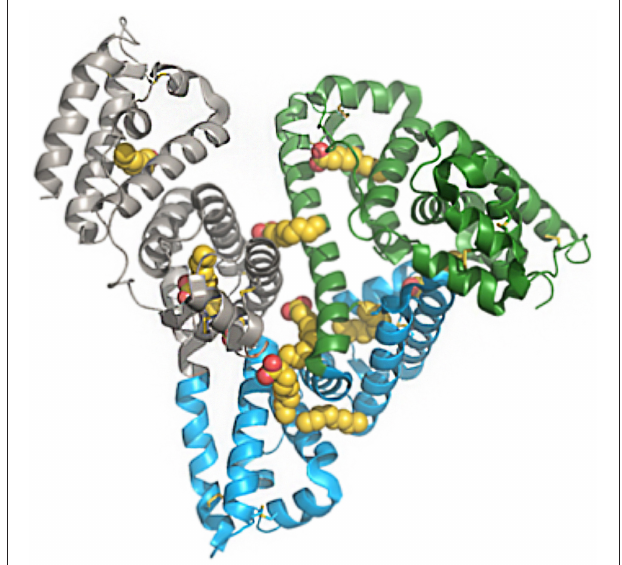
FIGURE 1 | Structure of human serum albumin, representing domains and fatty-acid binding sites. Green, subdomain I; blue, subdomain II; gray, subdomain III; yellow/red, fatty acids. The PDB file has code 1E7E resolved to 2.5 Å resolution. Reprinted from Bhattacharya et al. (10). Copyright 2018, with permission from